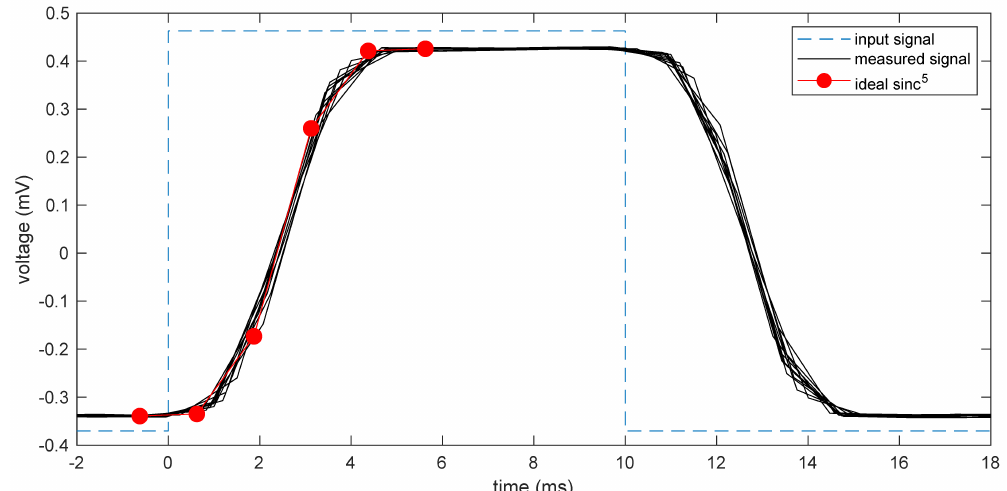
Figure 12. Measured output from the EMG signal chain corresponding to a rectangular impulse digitally provided (and hence shown not to scale). An ensemble of ten different measures across a two-minute time span is reported to show clock synchronization effectiveness. For reference, the ideal step response of a sinc 5 digital filter like those used in the analog front-end is reported as obtained by a VHDL simulation. The ODR was set to 800 Hz and so samples are 1.25 ms apart.